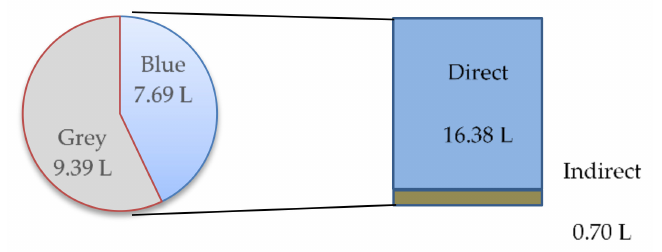
Figure 3. The water footprint of 1 L of